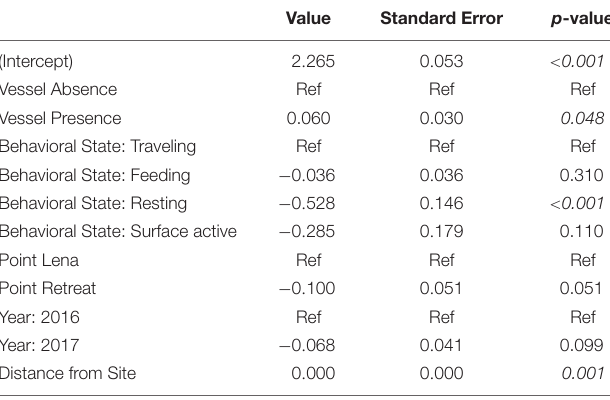
TABLE 6 | Estimated coefficients and standard errors from the AICc-best linear mixed effects model of the effect of vessel presence on sqrt (Speed) ( n = 3,136 fixes) while controlling for behavioral state, year, location, and distance from site.